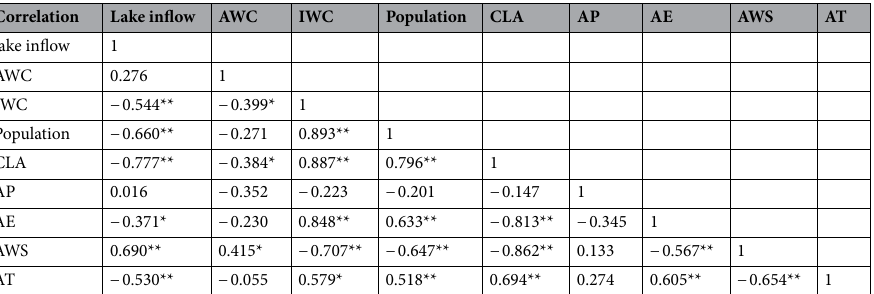
Table 4. Correlation matrix between lake inflow and influencing factors. AWC is agricultural water consumption; IWC is industrial water consumption; CLA is cultivated land area; AP is annual precipitation; AE is annual evaporation; AWS is average wind speed; AT is average temperature; ** is significantly correlated at 0.01 level, *is significantly correlated at 0.05 level.